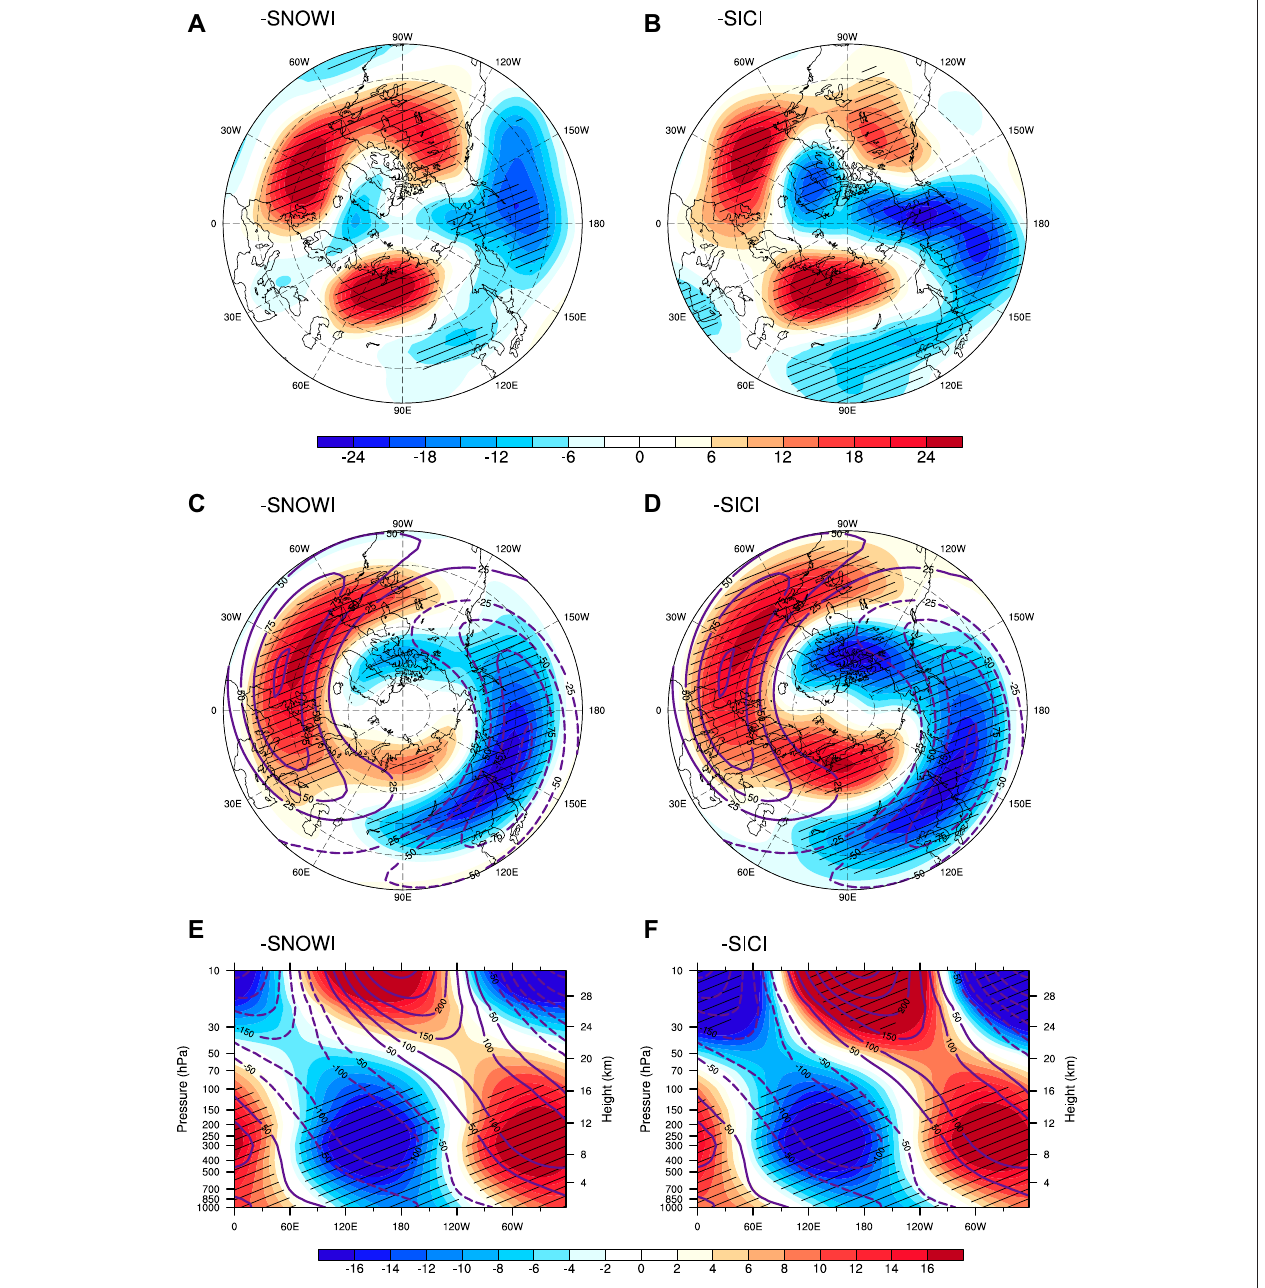
FIGURE7| Regressionsof500 hPageopotentialheight(m)inJanuary – Februaryagainstthe (A) negativeOctoberSNOWIand (B) negativeJanuary – FebruarySICI during 1979 – 2017. (C,D) and (E,F) are the same as (A,B) but for the zonal wavenumber-1 component of geopotential height at 500 hPa (shading; m) and longitude- pressure sections of the zonal wavenumber-1 component of geopotential height along 50 ° N (shading; m). Contours in (C – F) denote the climatological zonal wavenumber-1 component of geopotential height (m). Regions with hatched patterns indicate that the anomalies are signi fi cant at the 90% con fi dence level.